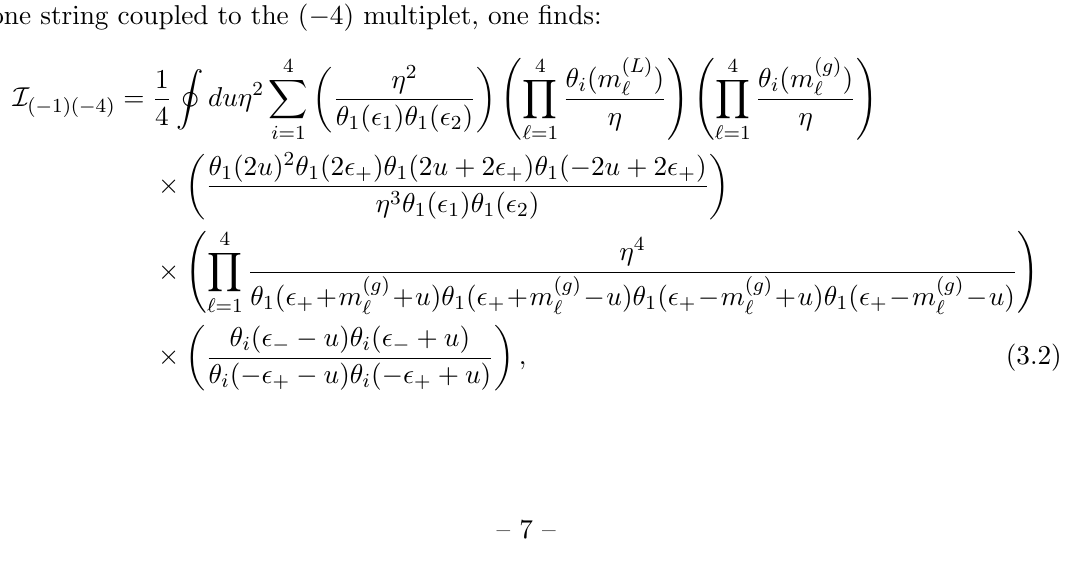
Figure 4 . Non-critical strings in M5 branes probing D p